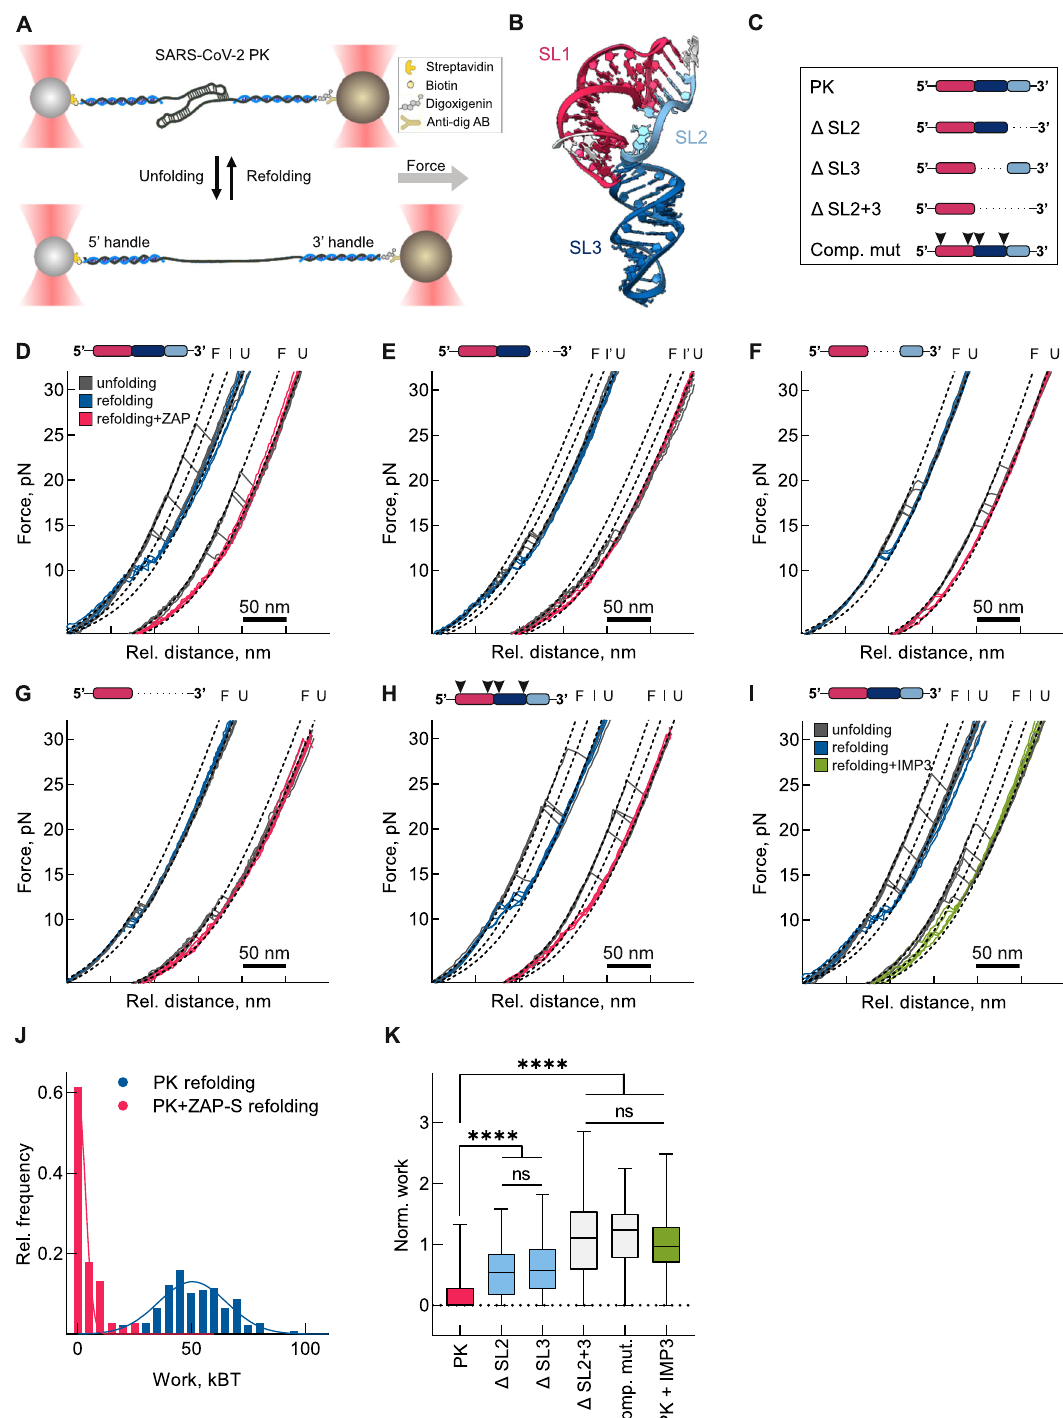
(Supplementary Figs. 5 and 6, Supplementary Table 1). In one population no refolding was seen (0.2 ± 0.3 nm), the second one showed similar step sizes during (un)folding (25.6 ± 2.8 nm), and the third one represented a partially refolded state, which was likely a simple hairpin based on the lower contour length change (15.9 ± 3.1 nm) (Supplementary Fig. 6, Supplementary Table 1). In the Δ SL3 RNA variant, (Fig. 5C, F), the RNA was predicted to fold into a shorter PK. In agreement with this prediction, we measured higher forces of unfolding (17.4 ± 1.3 pN) and hysteresis during refolding, yet the change in contour length